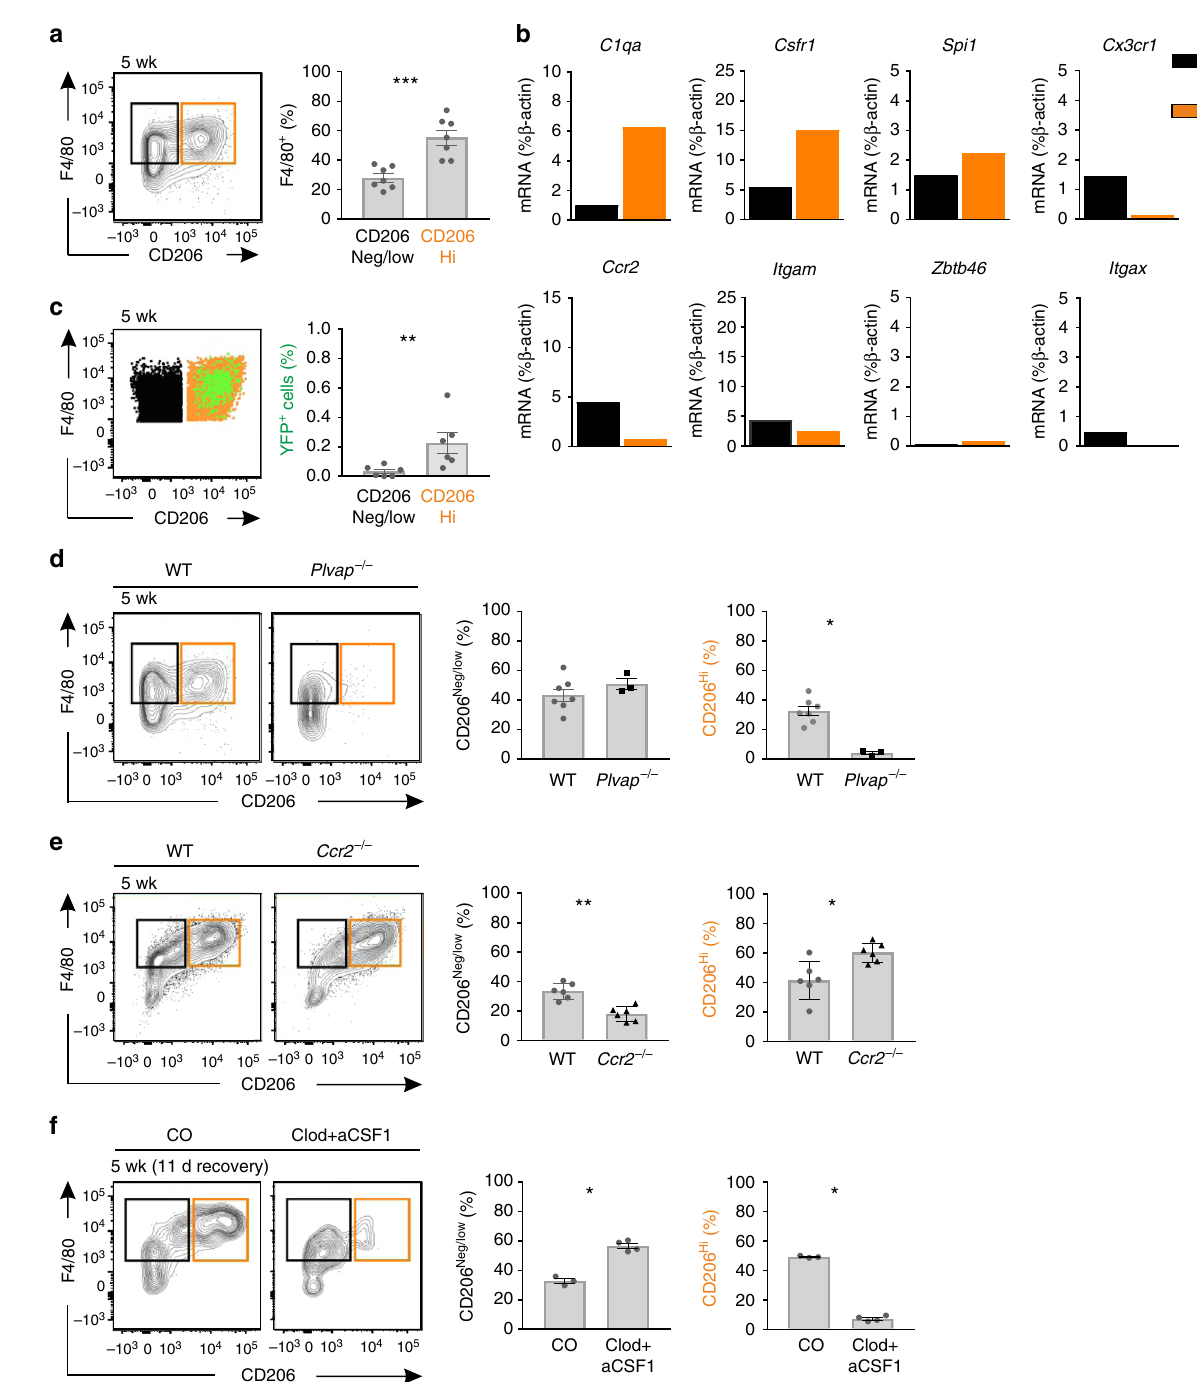
NATURE COMMUNICATIONS| (2019) 10:281